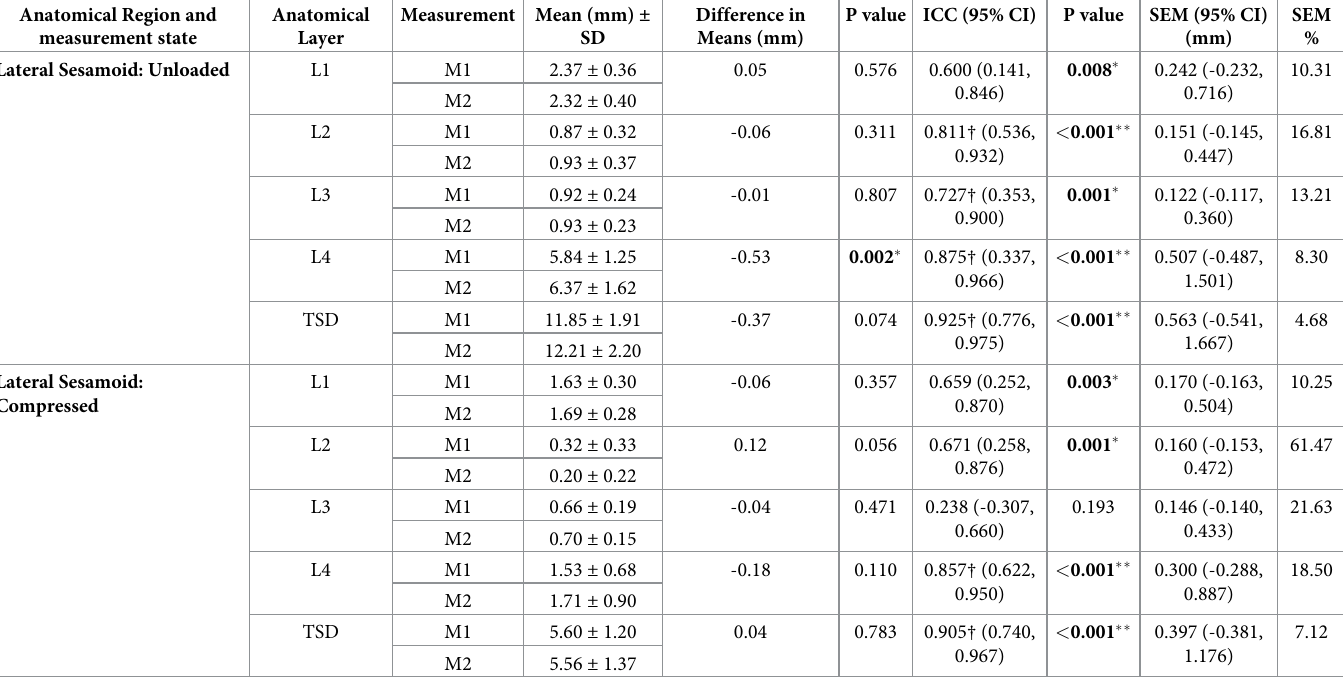
Table 3. Results for intra-observer reliability testing of skin and fat pad thickness at the lateral sesamoid foot region. Anatomical Region and measurement